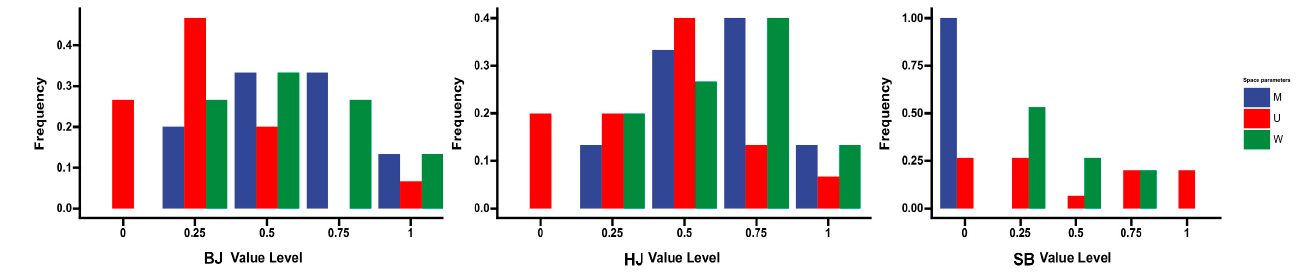
Figure 11. Spatial structure of MWLs. The W stands for angular scale, M stands for mixing degree, and U stands for the size ratio.